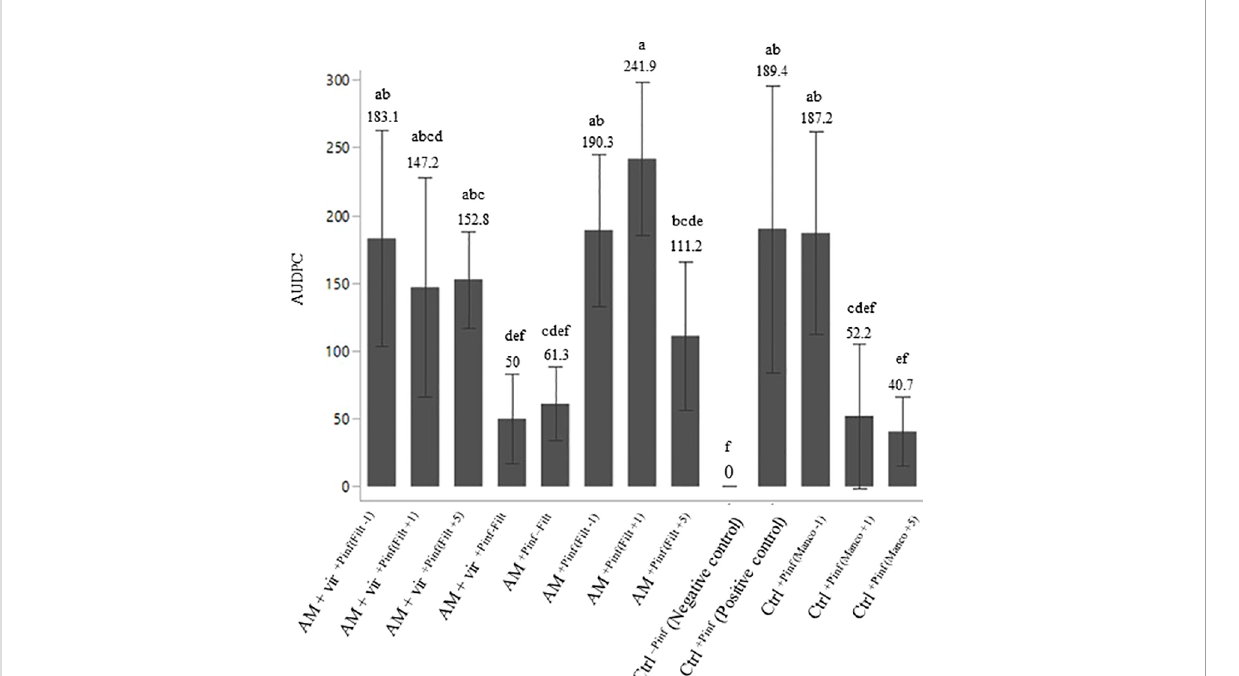
FIGURE 5 Area under disease progress curve (AUDPC) of potato plants grown 10 weeks in greenhouse in association (AM) or not (Ctrl) with R. irregularis MUCL 41833 propagules, entrapped (AM + vir) or not with a culture fi ltrate of T. virens MUCL 18139 and sprayed (+Filt) or not (-Filt) with a culture fi ltrate of T. virens MUCL 18139 or with Mancozeb (Manco) fungicide at different spraying times (-1,+1,+5) estimated 15 days post-infection with P. infestans MUCL 54981. The fi ltrate or fungicide was sprayed at 1 day pre- P. infestans inoculation ( -1 ), at 1 ( +1 ) or at 5 ( +5 ) days post- P. infestans inoculation. Values are expressed as the mean ± SD ( n = 8). Values followed by identical letters did not differ signi fi cantly at p ≤ 0.05 (one-way ANOVA and Tukey ’ s